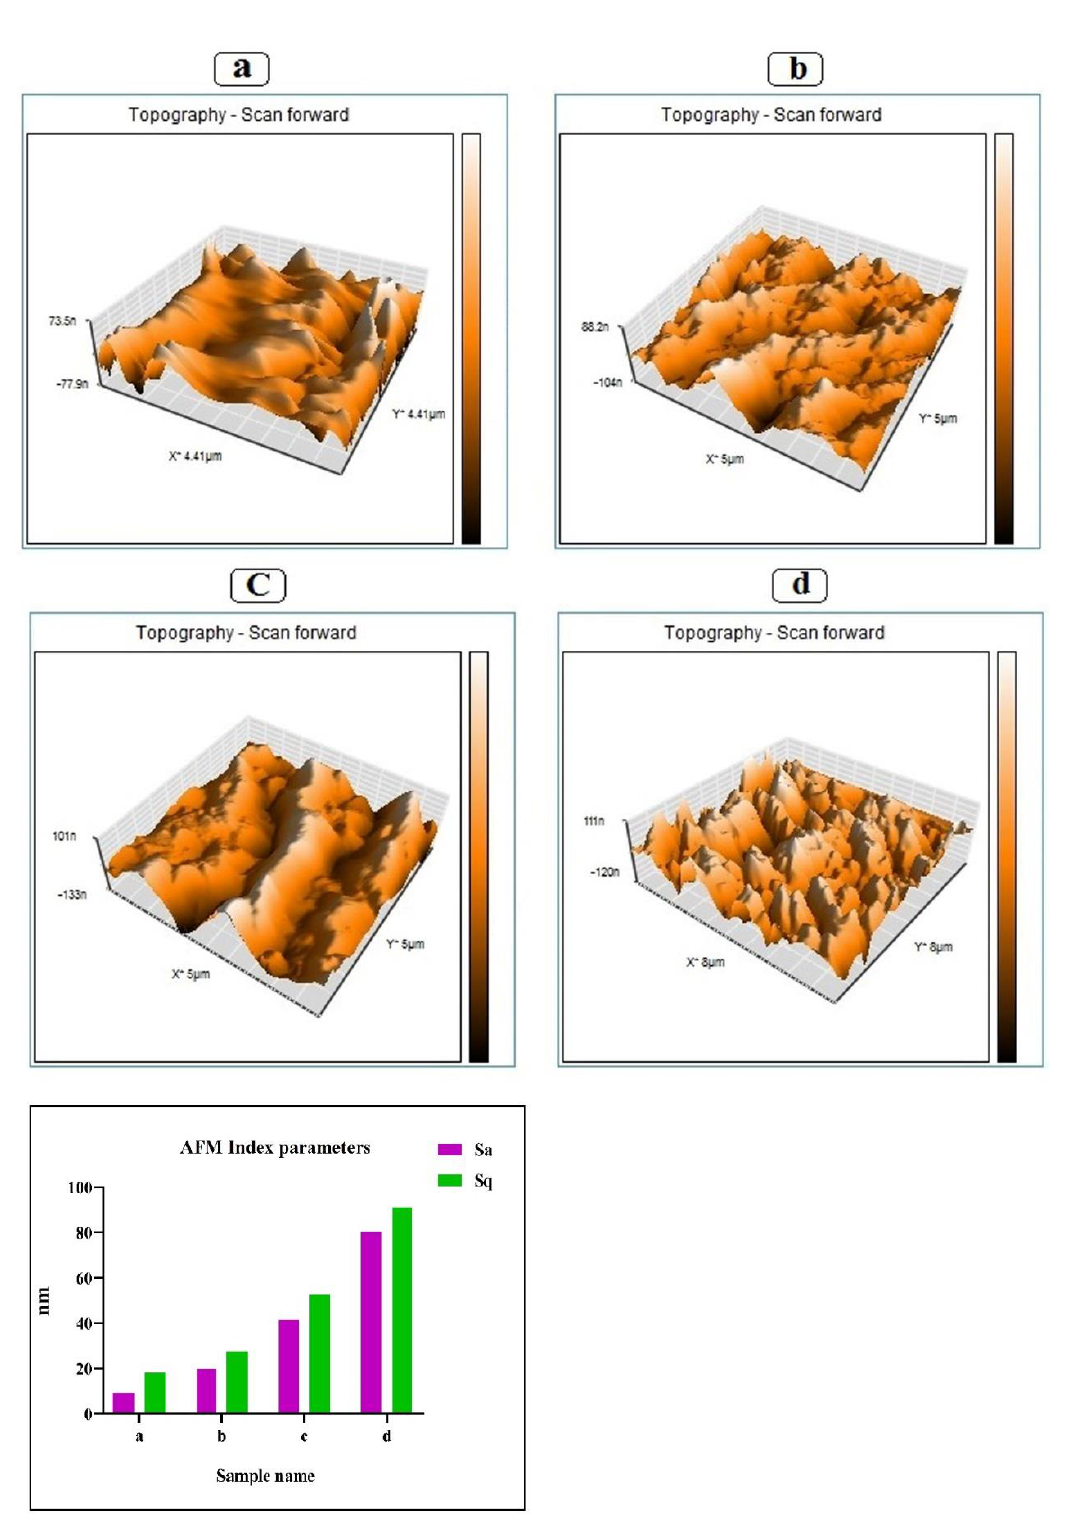
Figure 3. AFM 3D images and index of G/PVA ( a ), G/PVA/CWE 9 ( b ), G/PVA/MEO 9 ( c ), and G/PVA/CWE 9/MEO 9 ( d ) active films. Sa: average roughness. Sq: root mean square roughness.